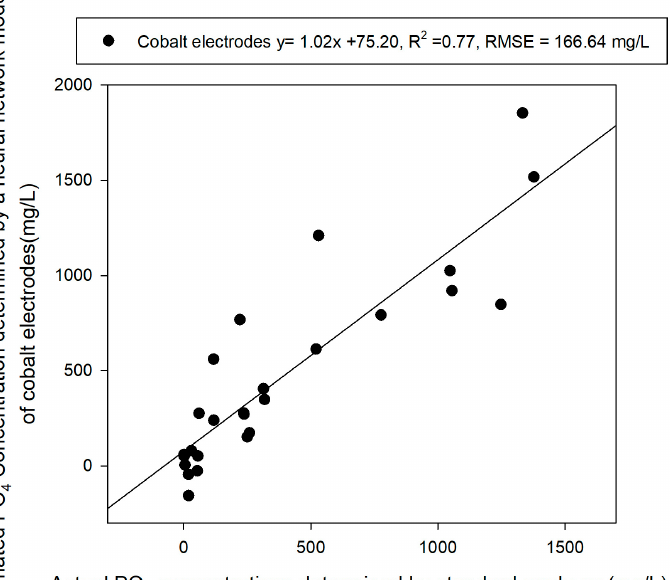
Figure 7. Test sample prediction results using ANN analysis with the EMF response of cobalt electrodes.